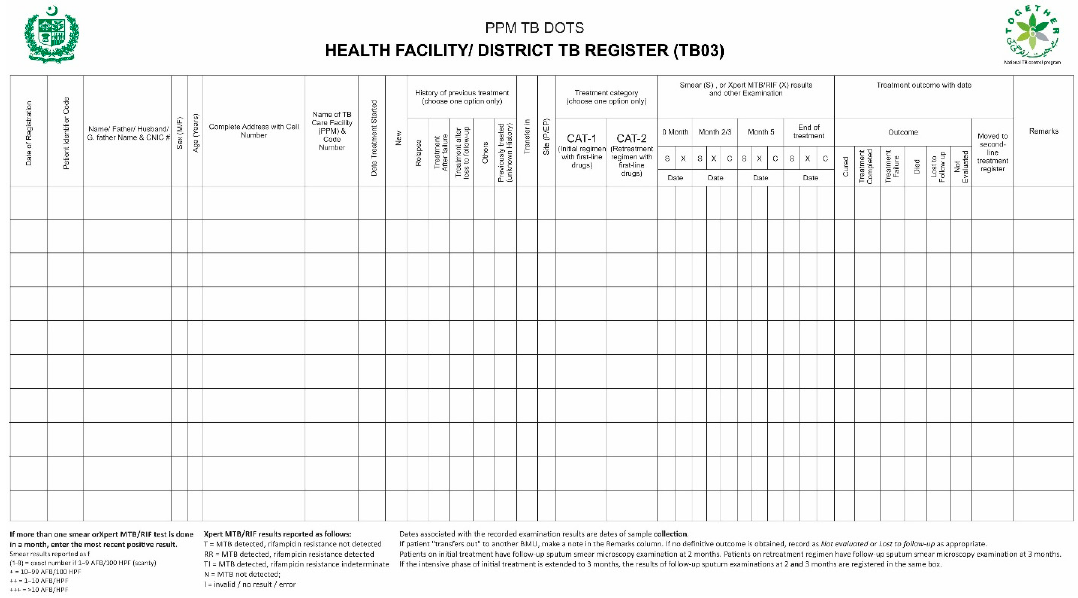
Figure 1. Original TB03 form used in routine data management process.